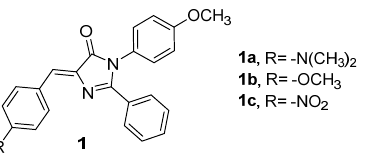
Figure 2. GFPc analogues with multiple phenyl substituents [15].